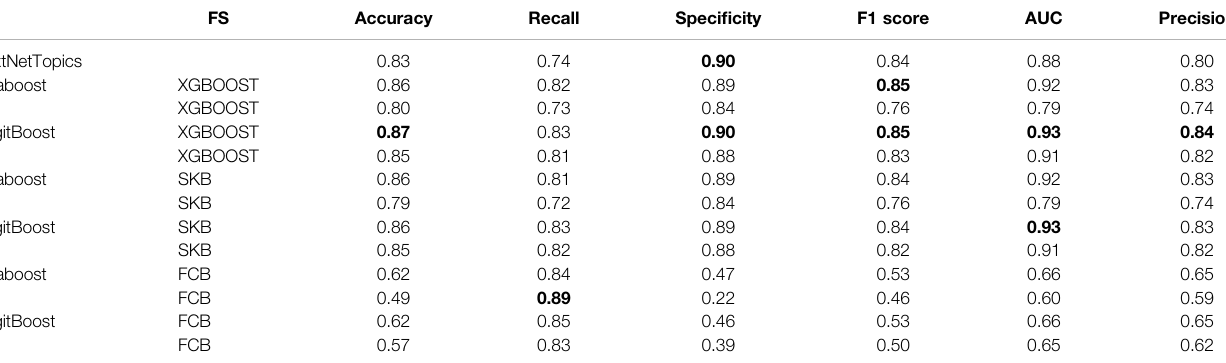
TABLE8| ResultsfordifferentalgorithmswithdifferentfeatureselectionsappliedonPubMed20kRCTdataset.Thetop60featuresareconsideredforeachfeatureselection algorithm.